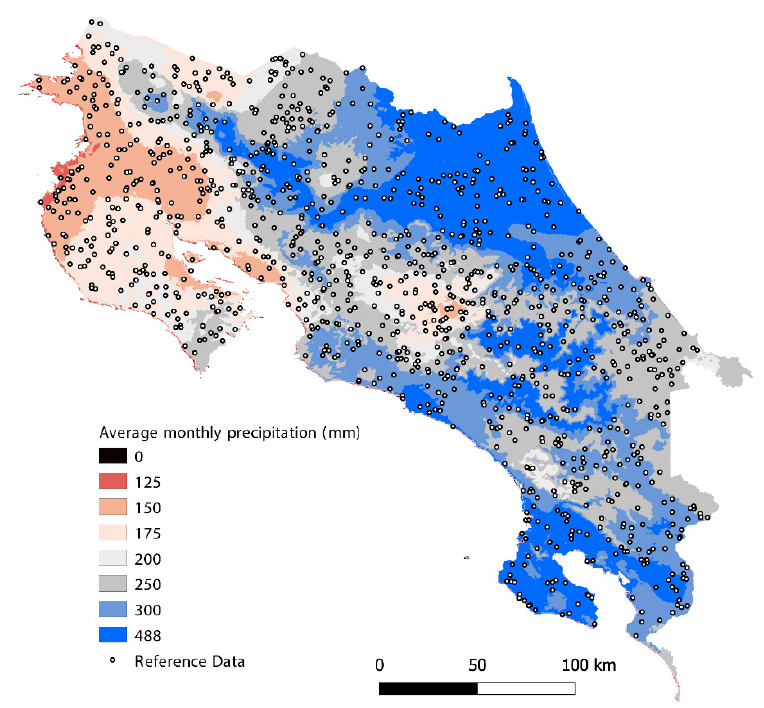
Figure A2. Precipitation across Costa Rica with locations of bias correction reference data shown. Note differences in rainfall between the east and west of the country.